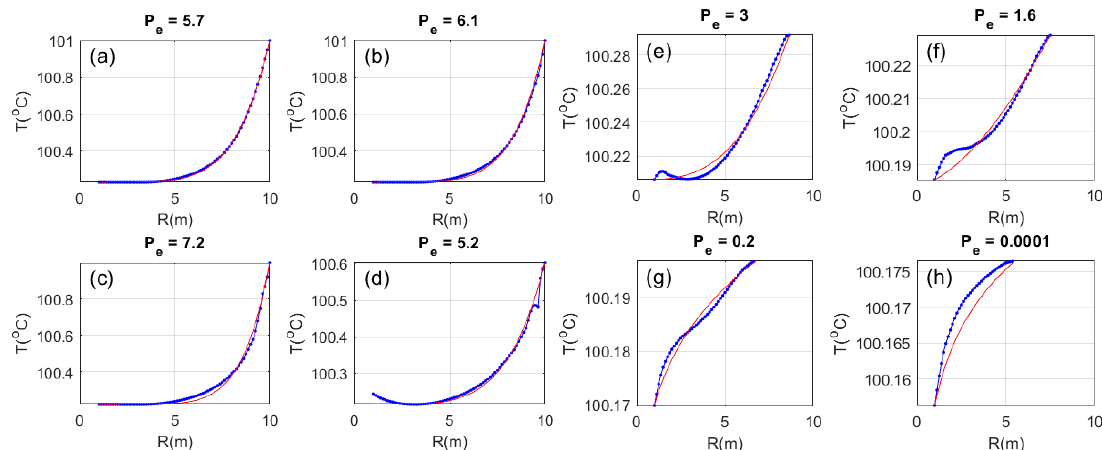
Figure 18. Following Figures 12 and 17, 2D analytic wellbore-centric radial temperature profiles (red traces) for given Peclet number superposed on 3D numerical model radial temperature distributions (blue dots) for 1 m radius wellbore embedded in 10-m radius crustal volume with a 2–3 m fracture-connectivity structure. From upper left, plots ( a – h ) show 3D model radial temperature distributions fit to 2D steady-state radial temperature distributions (5) governed by numbers P e = r 0 φ v 0 /D. The Peclet number for the fracture-connectivity horizon in plot ( c ) is 7. Stepping away from the horizon in 1.5 m intervals, the Peclet numbers decline below the influx layer, plots ( a , b ) with P e = 5.7 and 6.1, and above the influx layer, plots ( d – h ) with P e = 5.2 to 0.0001.